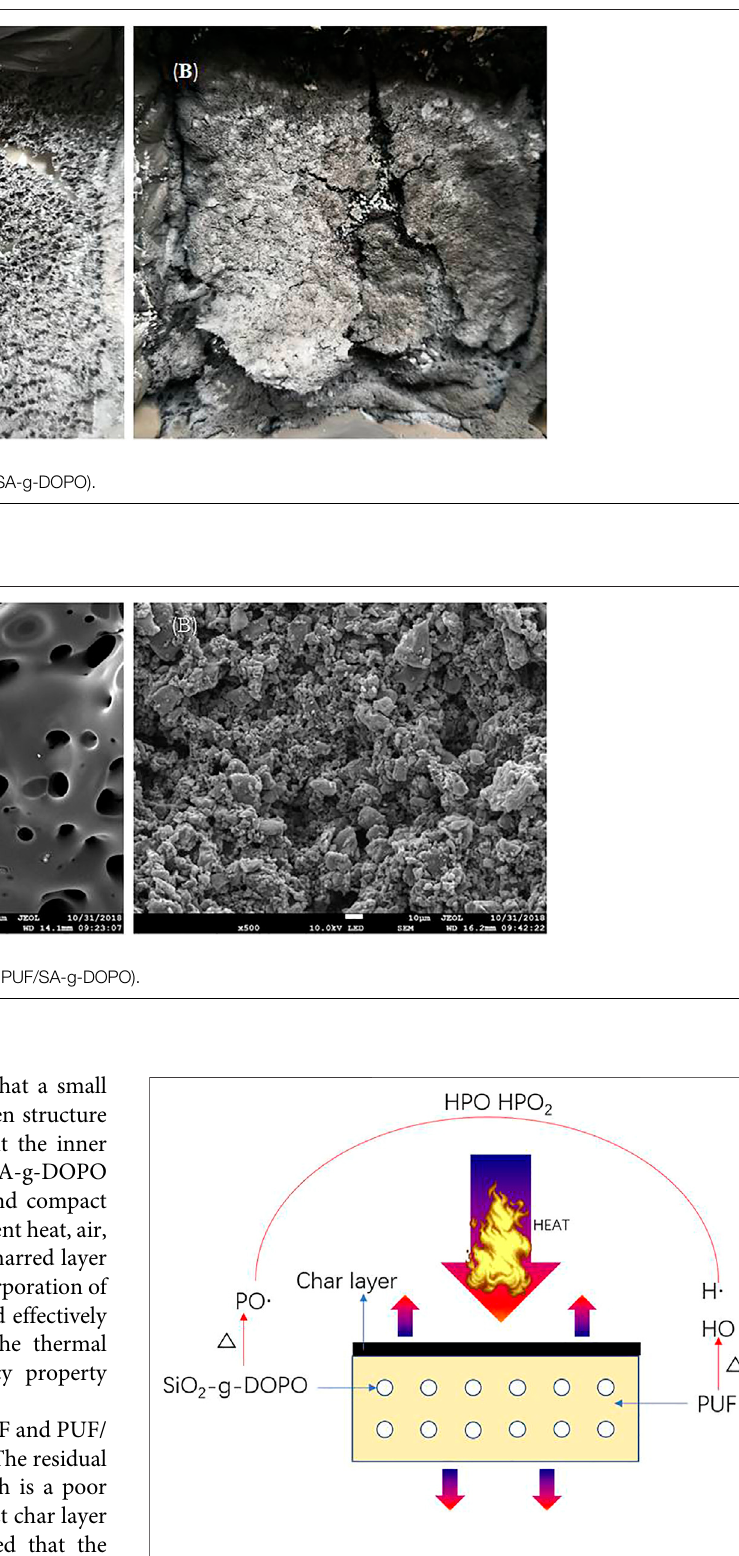
FIGURE 12 | Possible mechanisms of fl ame retardancy of PUF/SA-g- DOPO